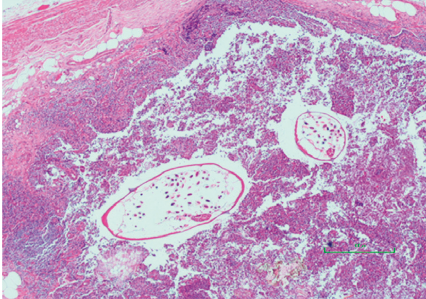
Figure 5: Appendix infested with E. vermicularis .